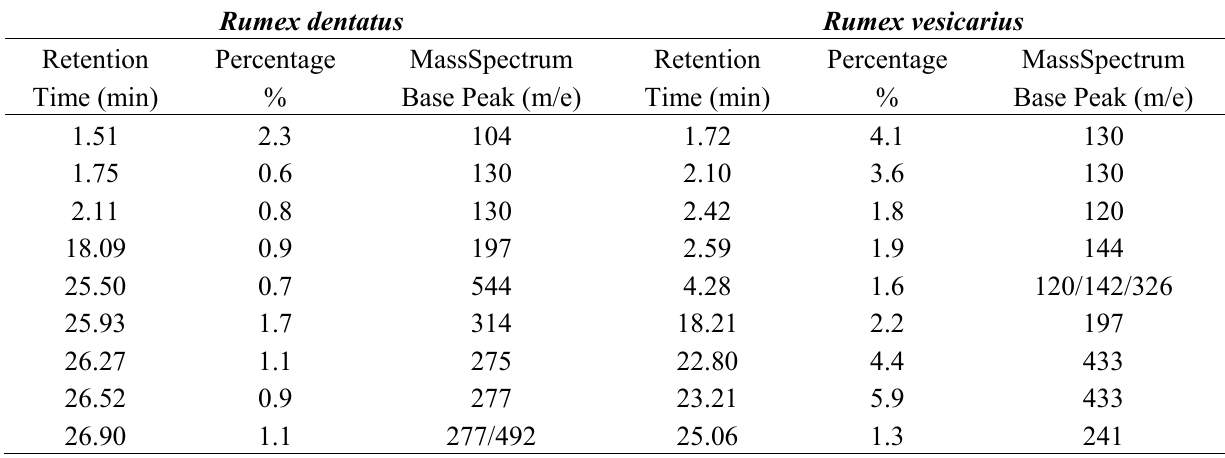
Table 4. Composition of the crude extracts of Rumex dentatus and Rumex vesicarius as analyzed by ESLCMS in the negative